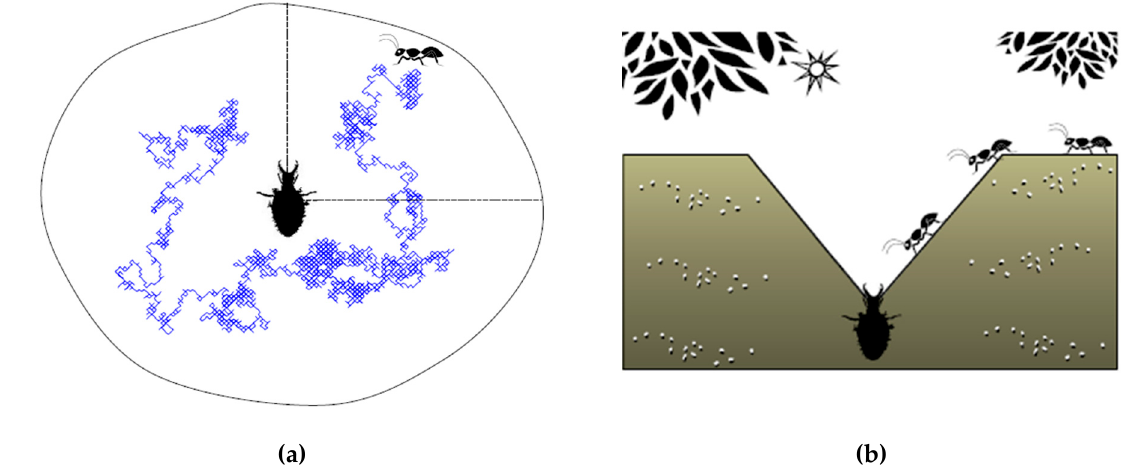
Figure 3. ( a ) Random walk of the prey inside the trap, and ( b ) hunting behavior of ant lions (after